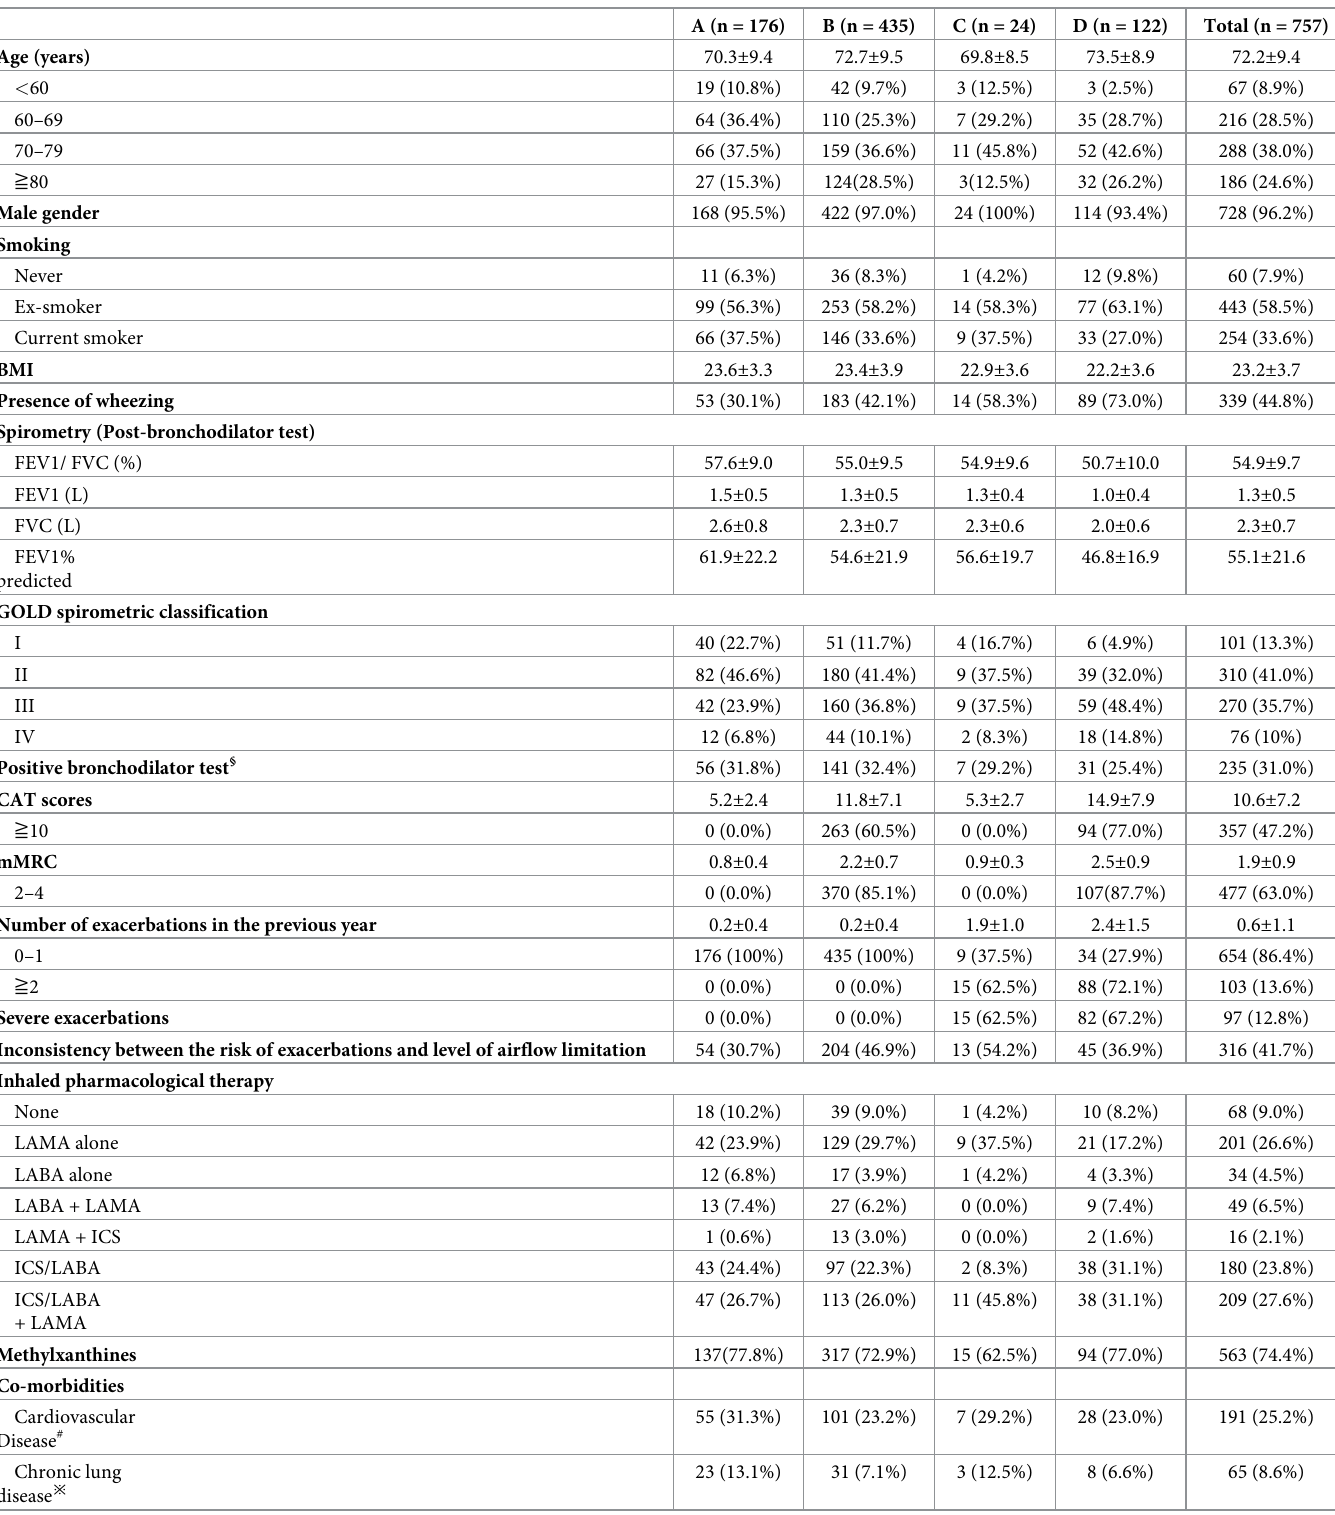
Table 1. Baseline characteristics of the enrolled